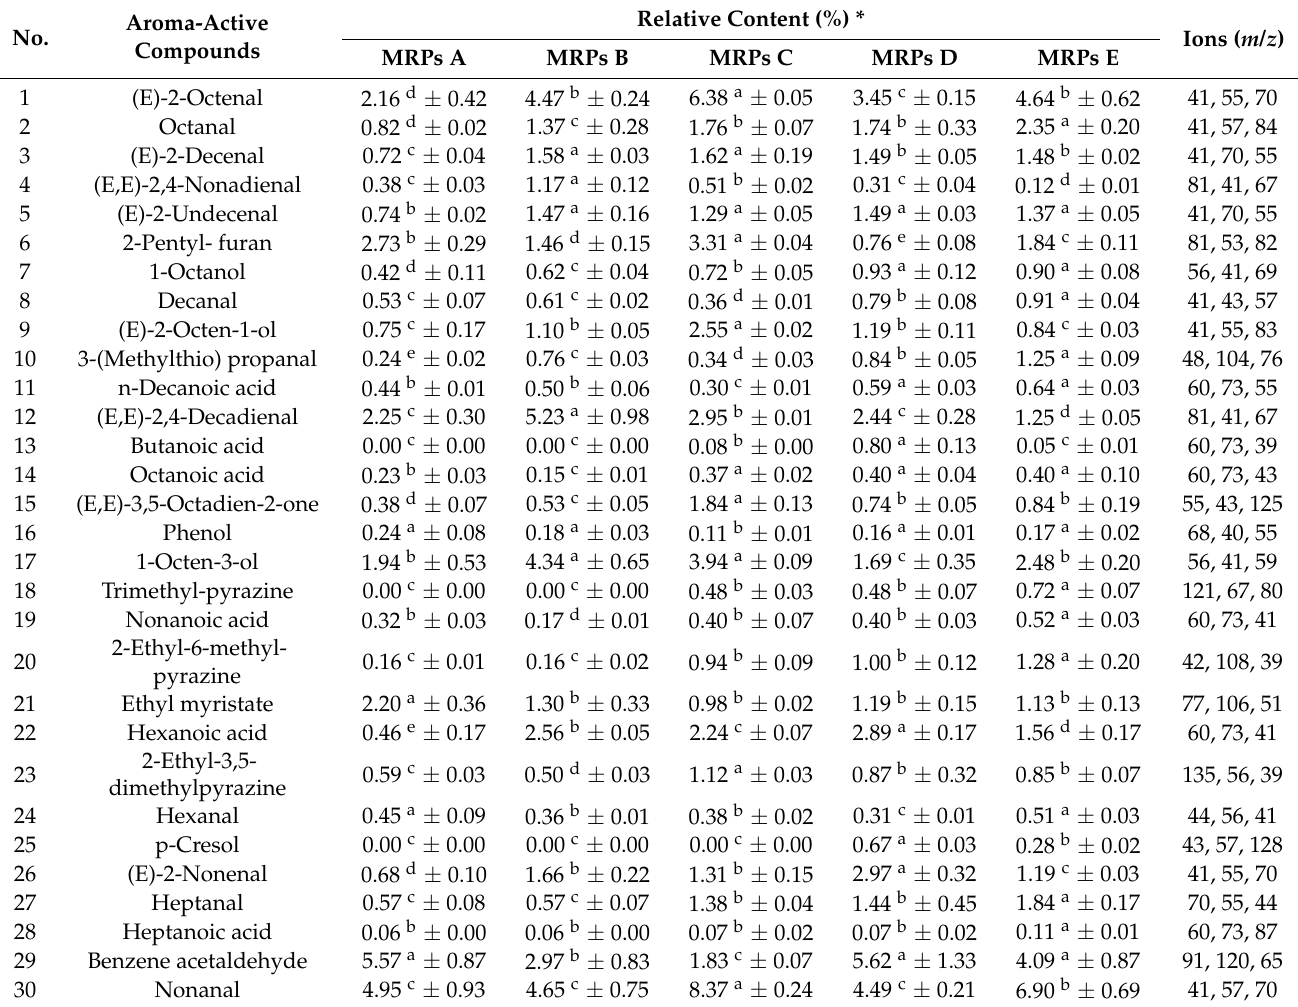
Table 2. The relative concentration of aroma-active compounds in